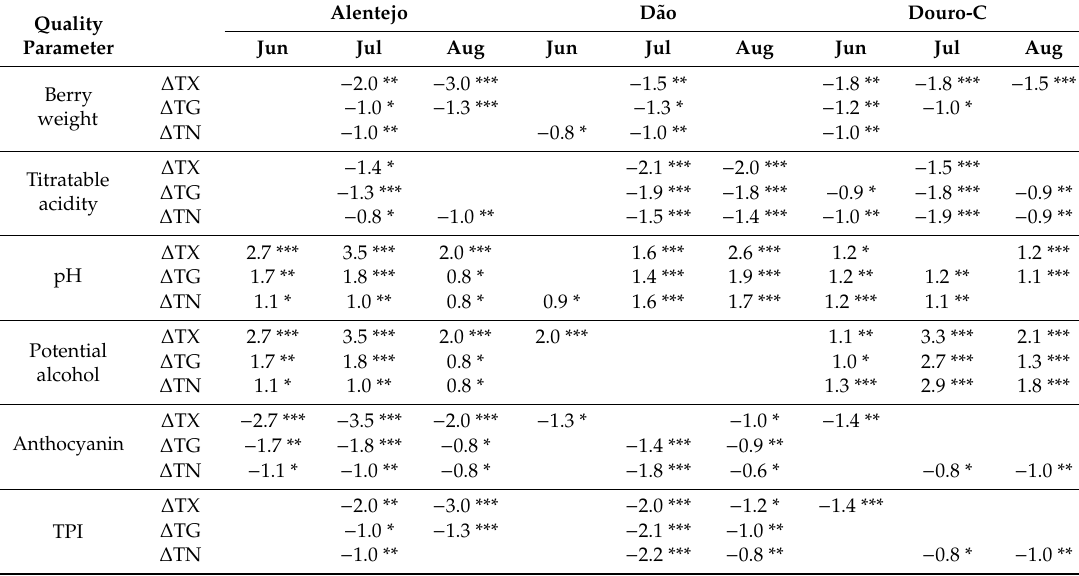
Table 4. Di ff erence (in ◦ C) between the clusters for monthly means of TX, TG and TN in June, July